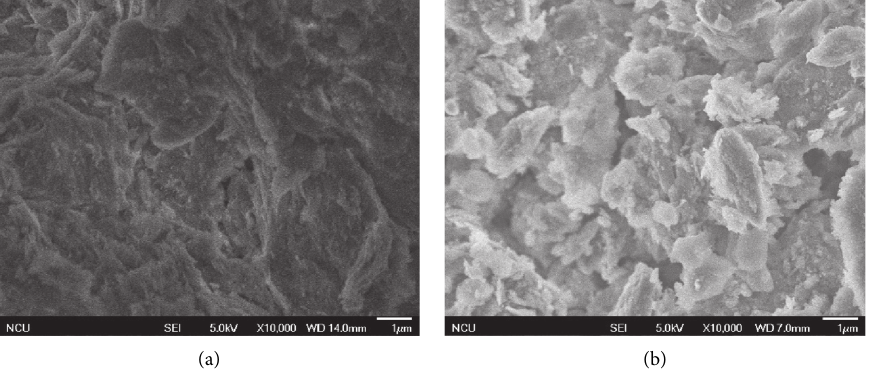
Figure 13: Microstructure of the laterite after alkaline-solution permeation: (a) pH � 11, t � 30d and (b) pH � 13, t �